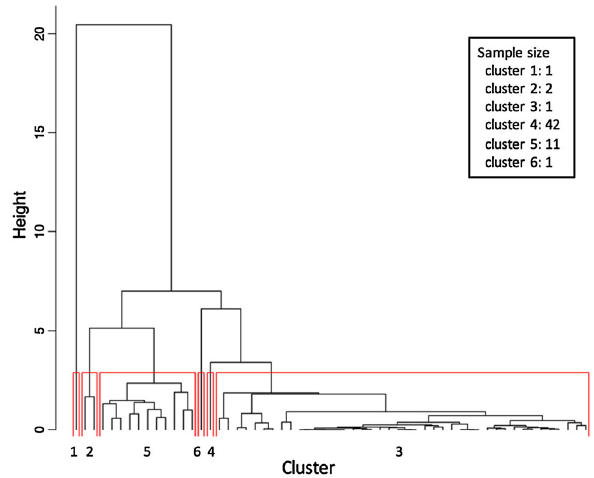
Fig. 2 Dendrogram for clustering salinity patterns of 58 tube